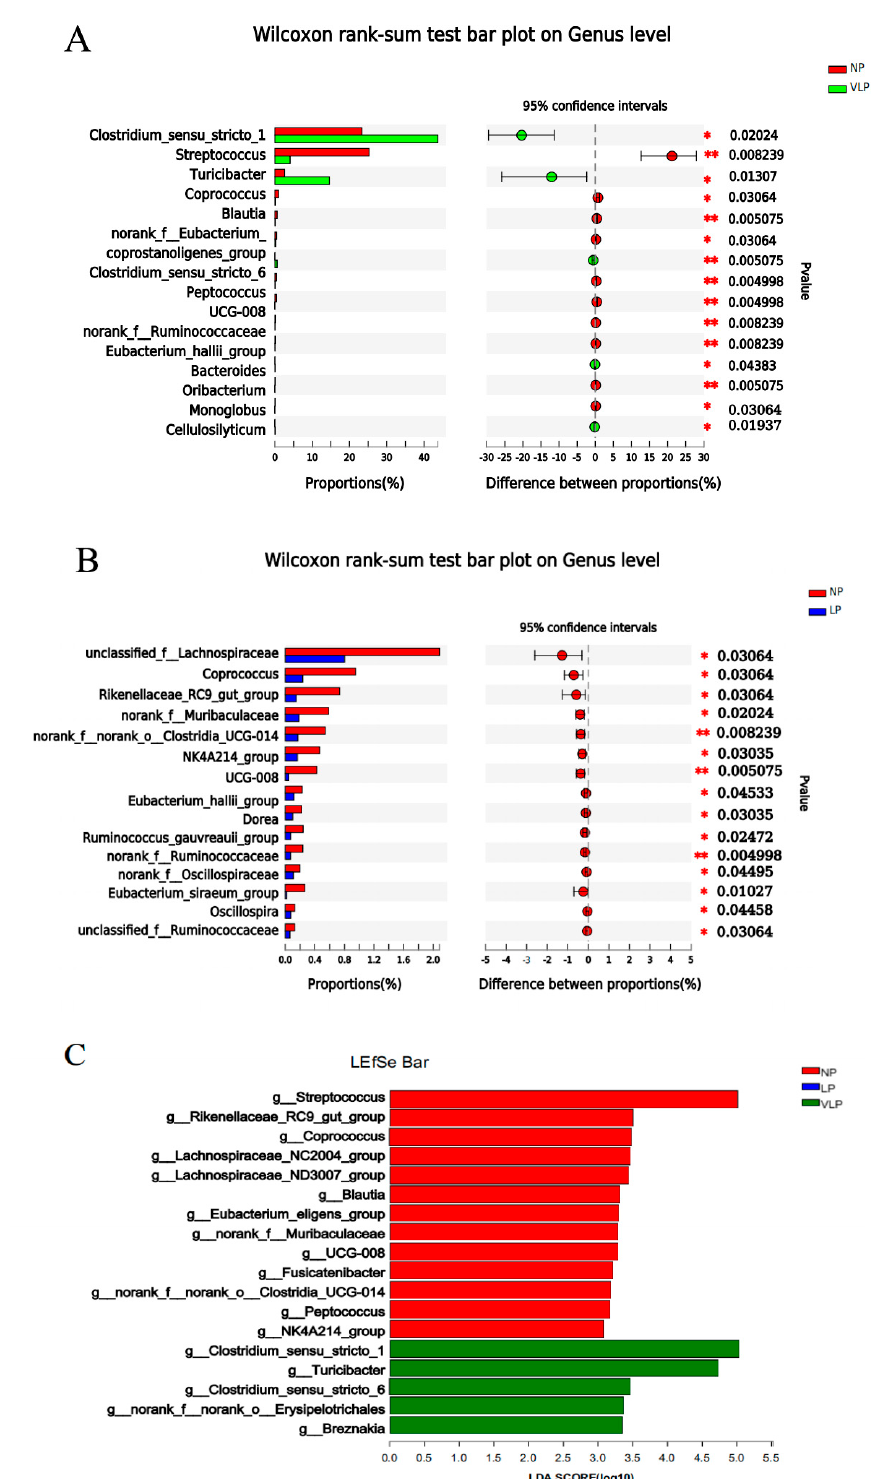
Figure 4. Different microbiota comparison by the student t-test on the genus of the colon is shown in ( A , B ). p -values (* p < 0.05, ** p < 0.01) are shown on the right. Identification of the most differentially abundant genera in the colon. The plot ( C ) is generated from Linear Discriminant Analysis Effect Size (LEfSe) analysis with CSS-normalized OTU table and displays taxa with LDA scores above 3.0 and p -values below 0.05. Genera enriched in the samples with the NP diet are indicated with red bars, genera enriched in the samples with the LP diet are indicated with blue bars and genera enriched in the samples with the VLP diet are indicated with green